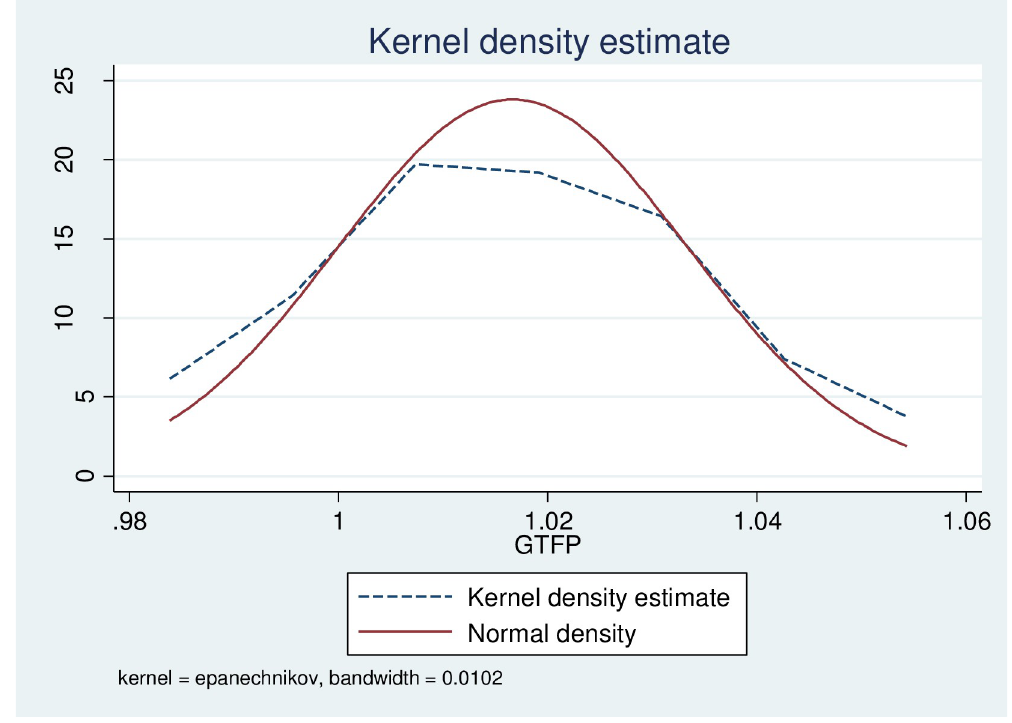
Fig 1. Green economic efficiency kernel density map for cities in the Hangzhou Bay Greater Bay